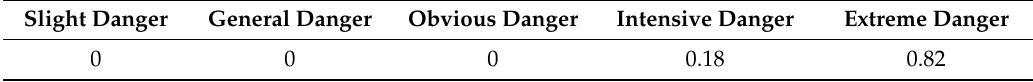
Table 8. The risk level of the Panzhihua City flooded area.